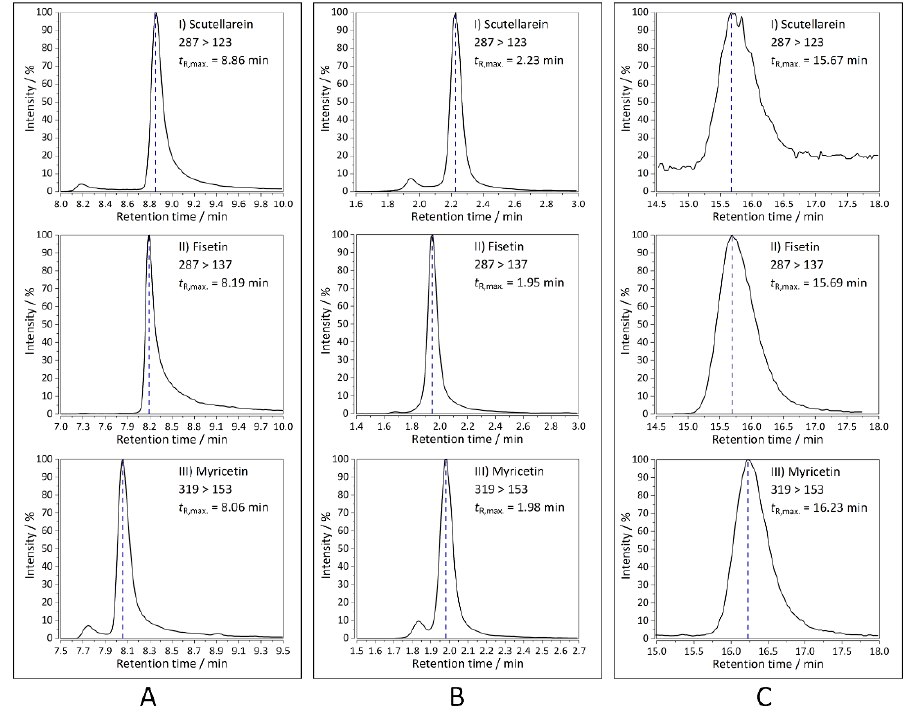
Figure 1. Representative multiple reaction monitoring (MRM) transitions and retention times as represented by scutellarein, fisetin, and myricetin, analyzed using HPLC-MS/MS on the: ( A ) K-C18, ( B ) K-F5, and ( C ) IAM.PC.DD2 chromatographic column.